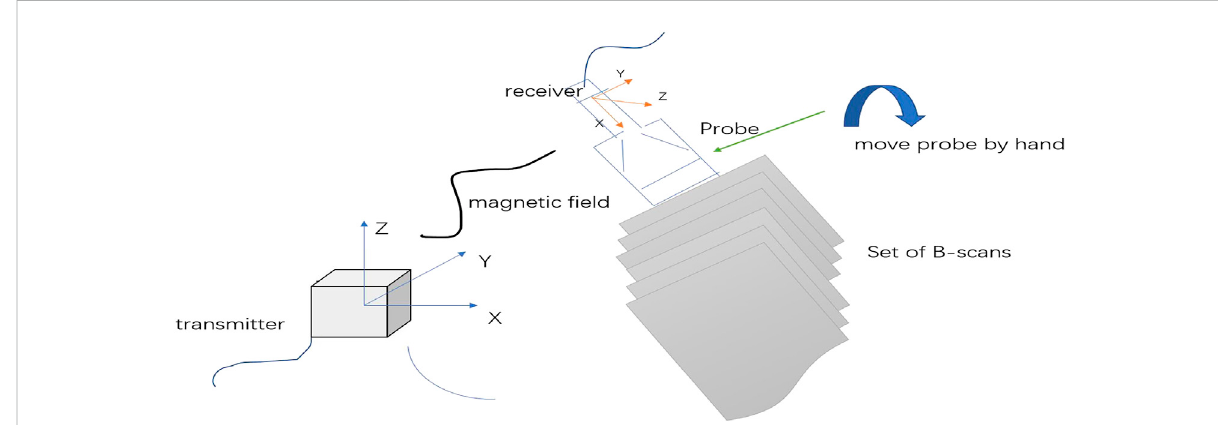
FIGURE 4 3D freehand ultrasound imaging. Freehand imaging allows the physician to move the probe freely so the B-scans can have arbitrary relative locations. The advantages of freehand scanning are low cost and scanning fl exibility.